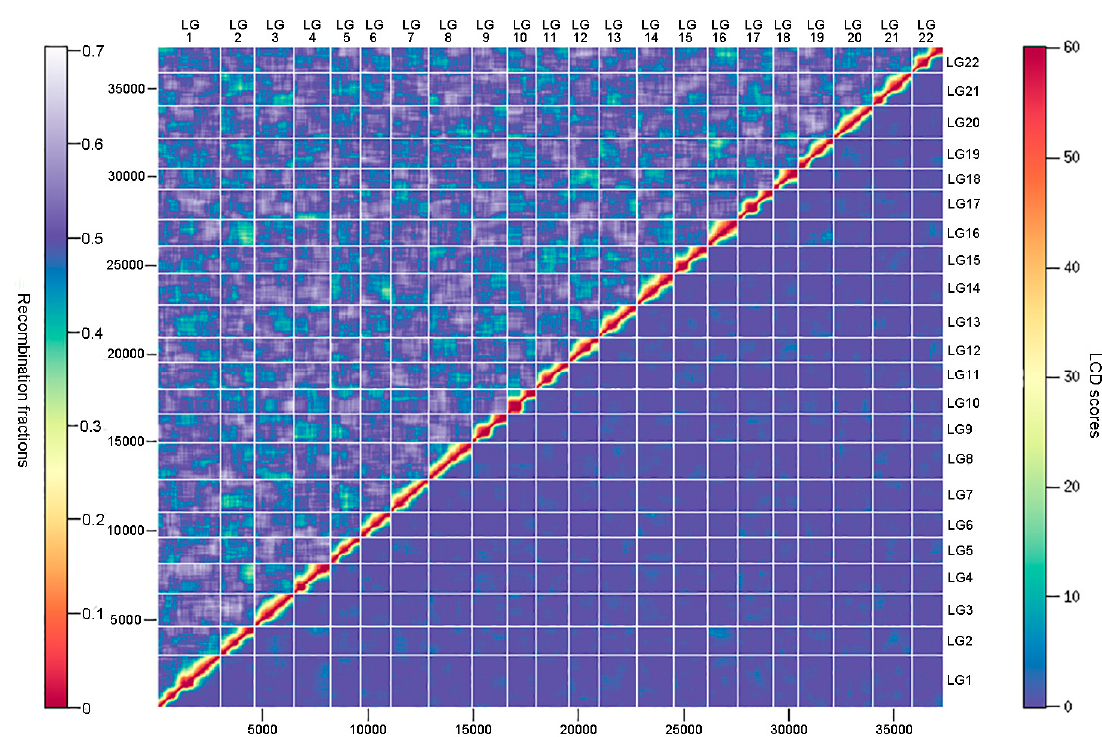
Figure 4. Heat map of recombination fractions (upper triangle) and logarithm of odds (LOD) scores (lower triangle) for all pairs of markers (SSGs) in the 22 linkage groups. LG represents linkage group.